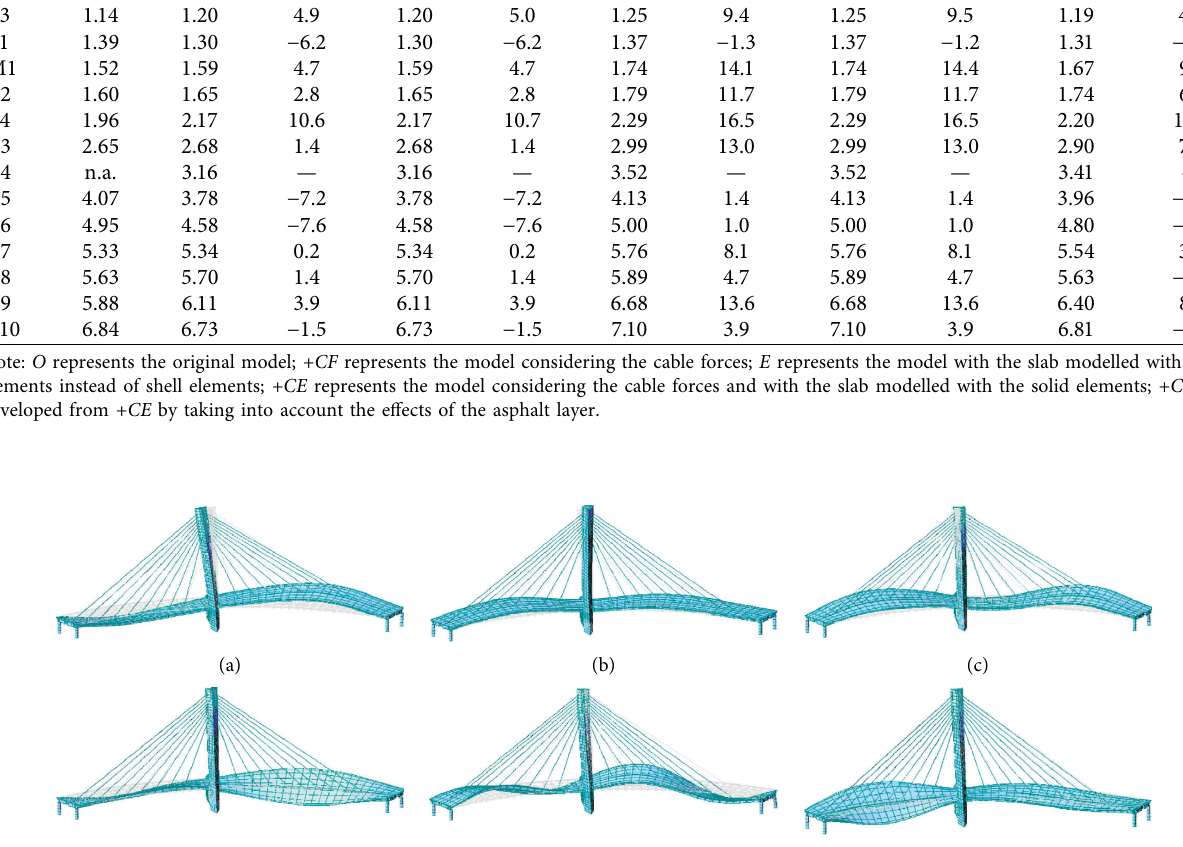
� 0.67Hz (B1). (b) f � 0.96Hz (B2). (c) FEM FEM